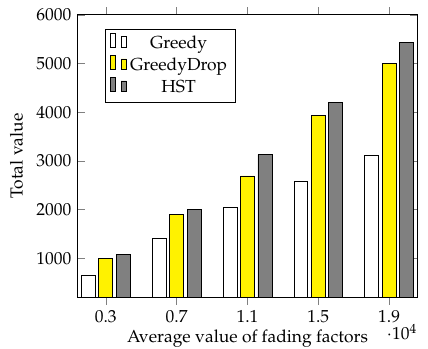
Figure 11. The effect of different amount of energy budget for non-FIFO tasks.